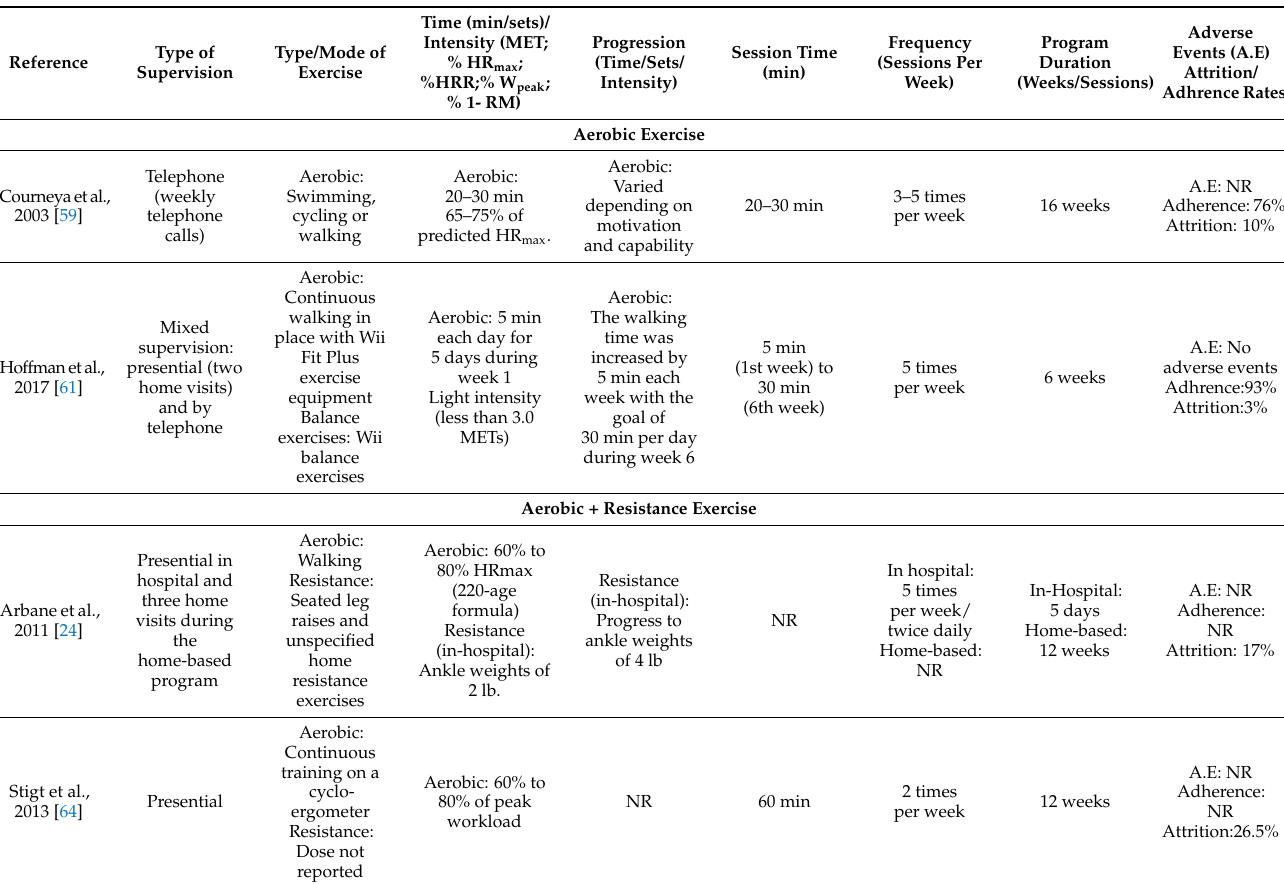
Table 2. Characteristics of the exercise training interventions (12